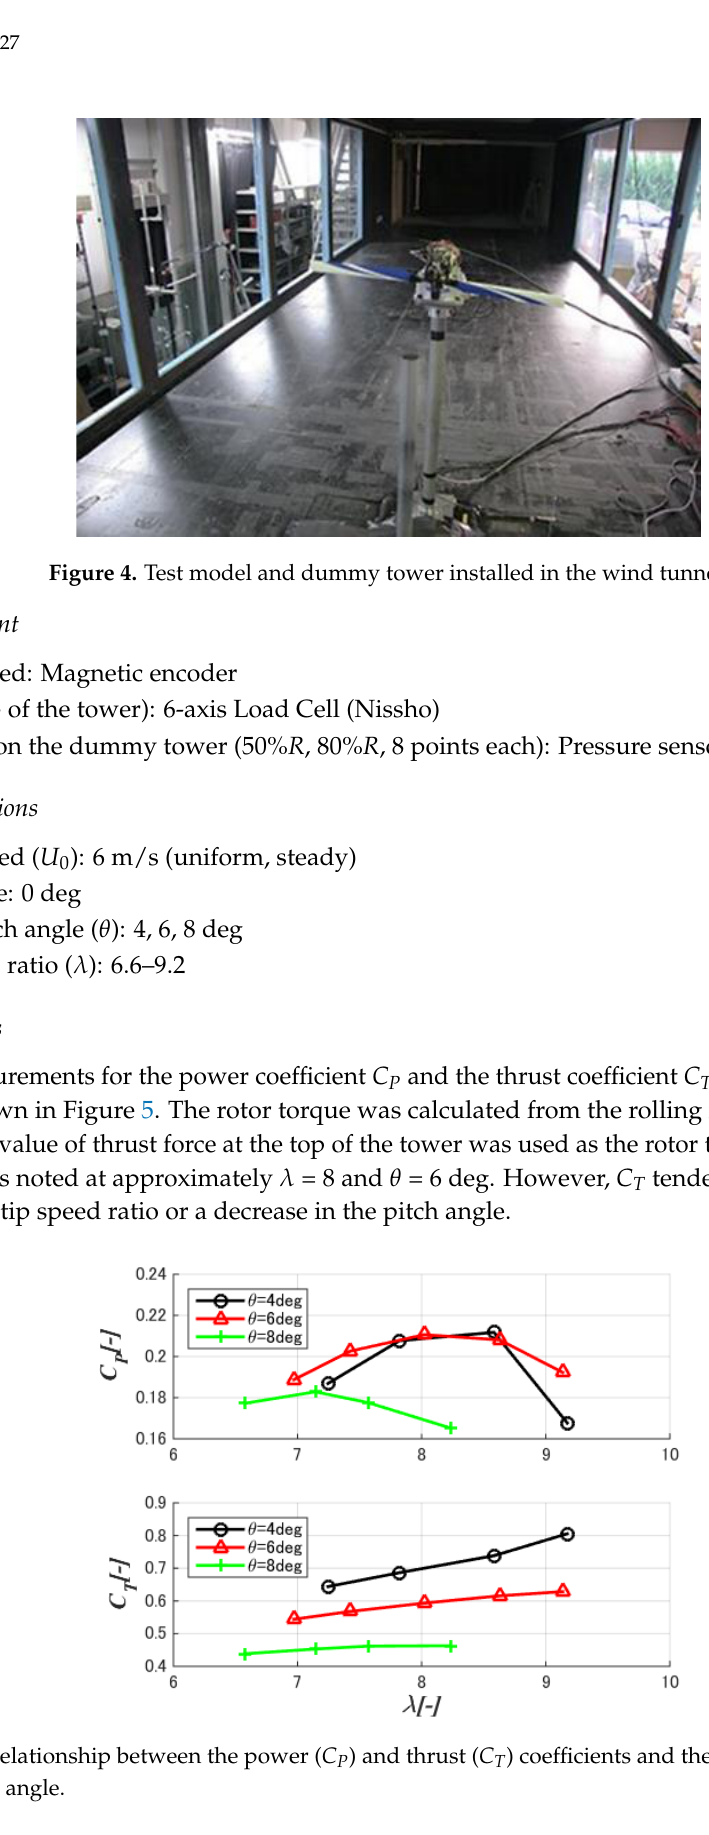
Figure 5. Relationship between the power ( C P ) and thrust ( C T ) coefficients and the tip speed ratio. θ, blade pitch angle.